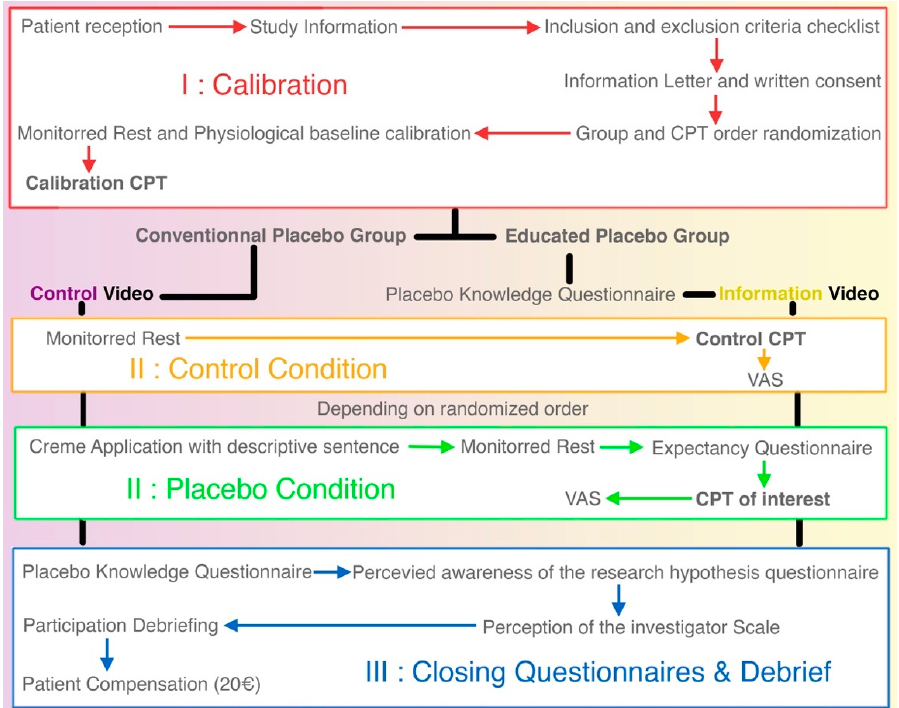
Figure 2. Detailed study flow for a subject. From top to bottom for an animated version of this figure, see: http://bit.ly/Placethic-Figure.